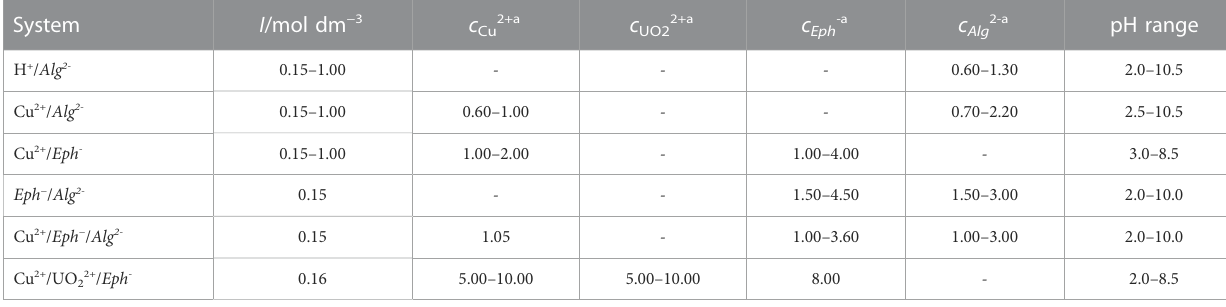
TABLE 1 Experimental details of the potentiometric investigations performed at T = 298.15K in NaCl (aq) .